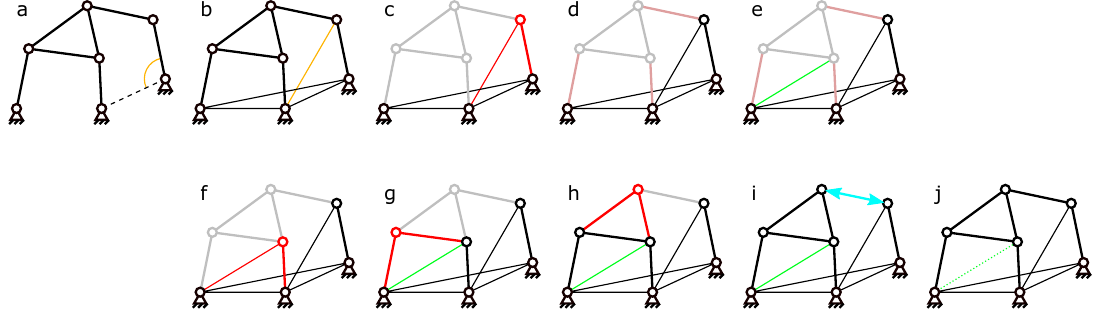
Figure 8. Analysis procedure for an unsolvable mechanism: ( a – c ) Same as Figure 6. ( d ) No computable two-link chain exists. ( e ) Add-link(green) is installed. ( f – h ) Same as Figure 6. ( i ) The distance between joints(blue) should be equal to link length. ( j ) Add-link length is